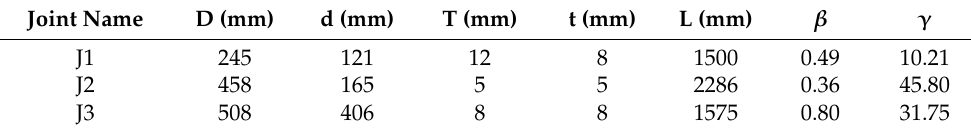
Table 1. Geometric properties of the CHS T-joints studied in this